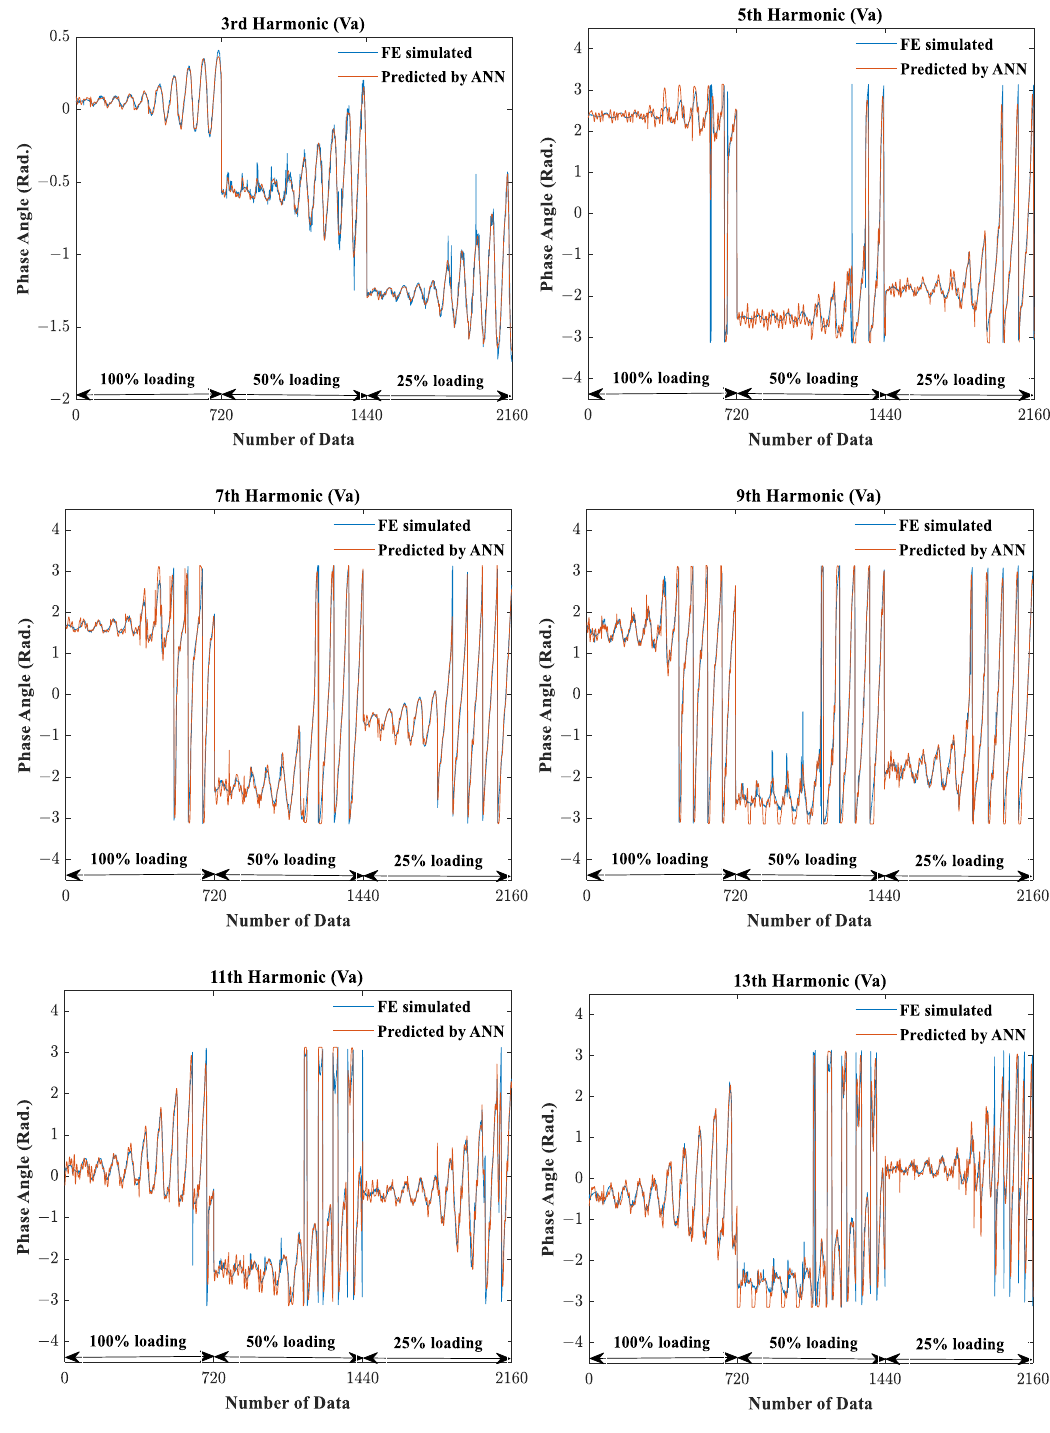
Figure 9. Phase angles of the non-fundamental harmonic phase voltages simulated by FE and predicted by the developed ANN model.